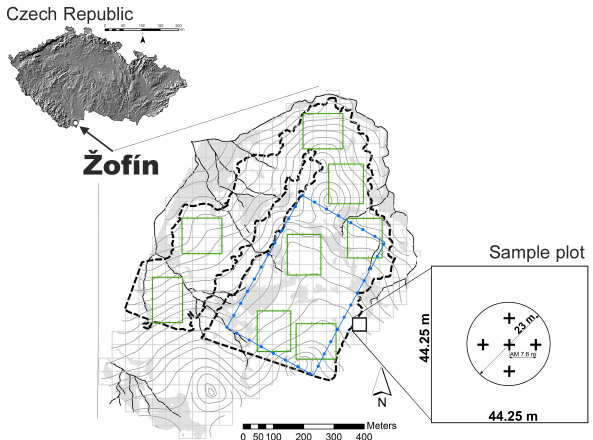
Figure 1. The study area: Žofínský Prales National Nature Reserve in the Novohradské mountains, Czech Republic. The dashed line shows the border between the (probably) historically anthropogeni- cally affected (32ha) and unaffected (42ha) zones; the grey solid lines represent contour lines; the black solid lines represent streams; grey areas show places significantly affected by water (semihydro- morphic and hydromorphic soils). The study area was overlain with a rectangular network of 353 sample plots (grid 44.25 × 44.25m); five regularly located soil profiles were studied in terms of soil prop- erties within each plot (crosses in the detail); water-affected sites were evaluated separately from a rectangular network (for details see Šamonil et al., 2011). One rectangle of 16.04ha served for the spatial analysis of releases in core series; eight rectangles of 1.50ha served for the spatial analysis of